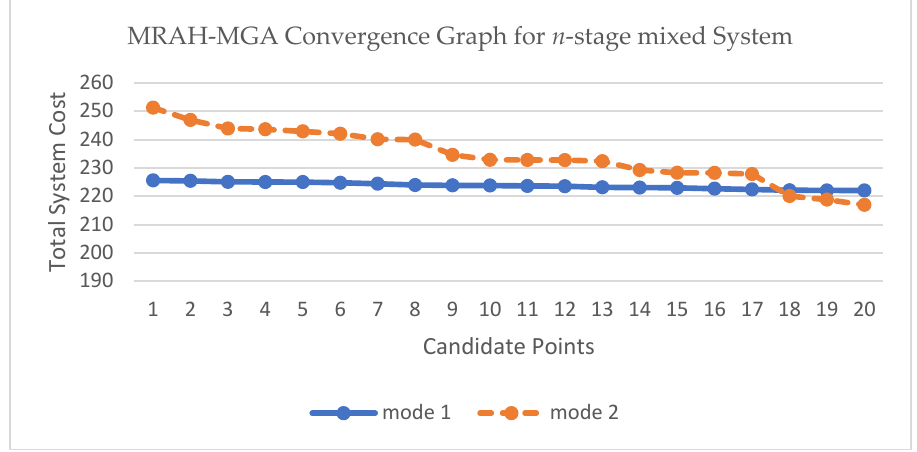
Figure 22. The convergence graph of the n -stage mixed system by utilizing the MRAH-MGA com- bined method. Table 43. The total system costs of 40 simulation runs obtained by MRAH–MGA for the n -stage mixed